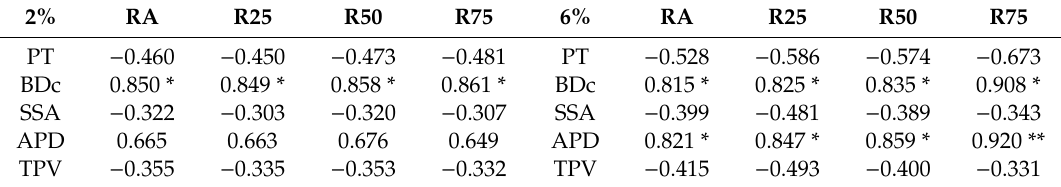
Table 5. Correlation coe ffi cients between biochar properties and soil evaporation